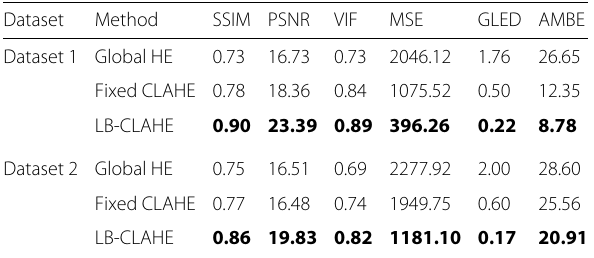
Table 5 Average similarity values for dataset 1 and dataset 2